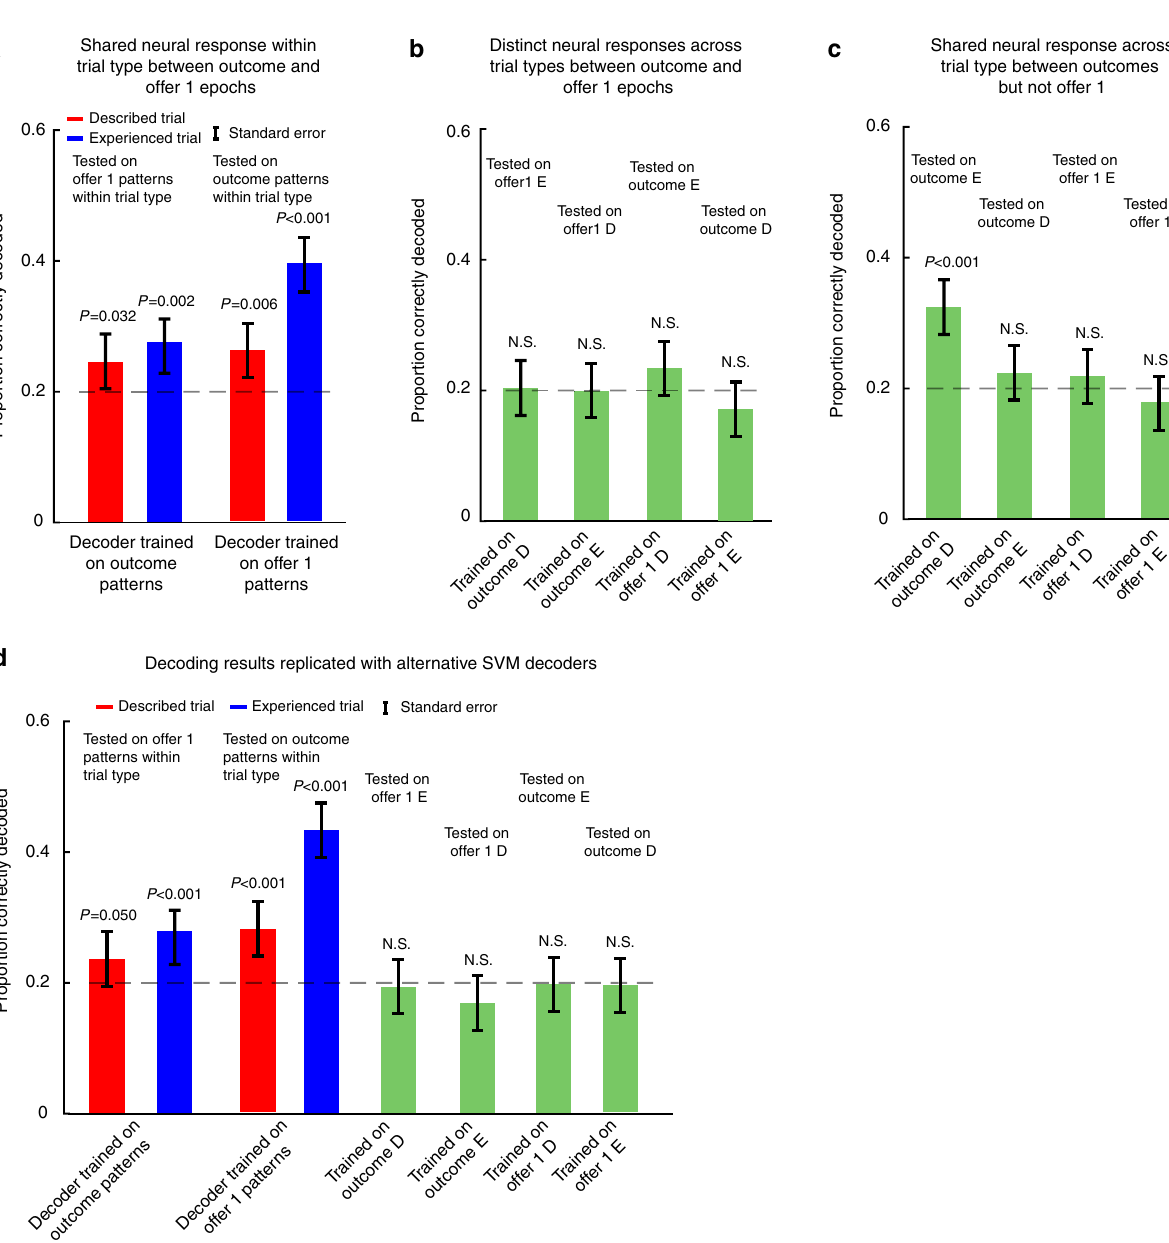
correlation coefficient (effect size) between (cid:2) 1 to (cid:2) 0.19 and 0.19 to 1, instead of 0.02.